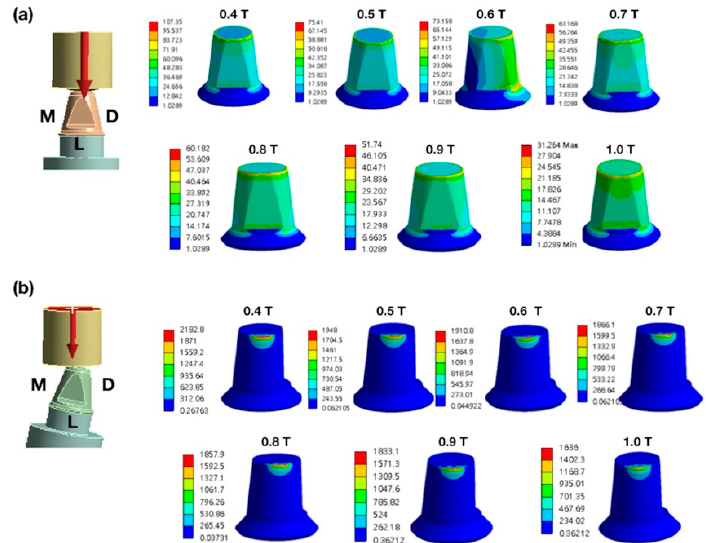
Figure 3. Distribution of stress in zirconia specimens. ( a ) The vertical load of 800 N from the lingual view. ( b ) Oblique 10-degree load of 800 N on the mesial marginal ridge. From left to right are the following loading models: top first row 0.4 T, 0.5 T, 0.6 T, and 0.7 T; top second row 0.8 T, 0.9 T, and 1.0 T; T: thickness (mm). D: distal. M: mesial. L: lingual.